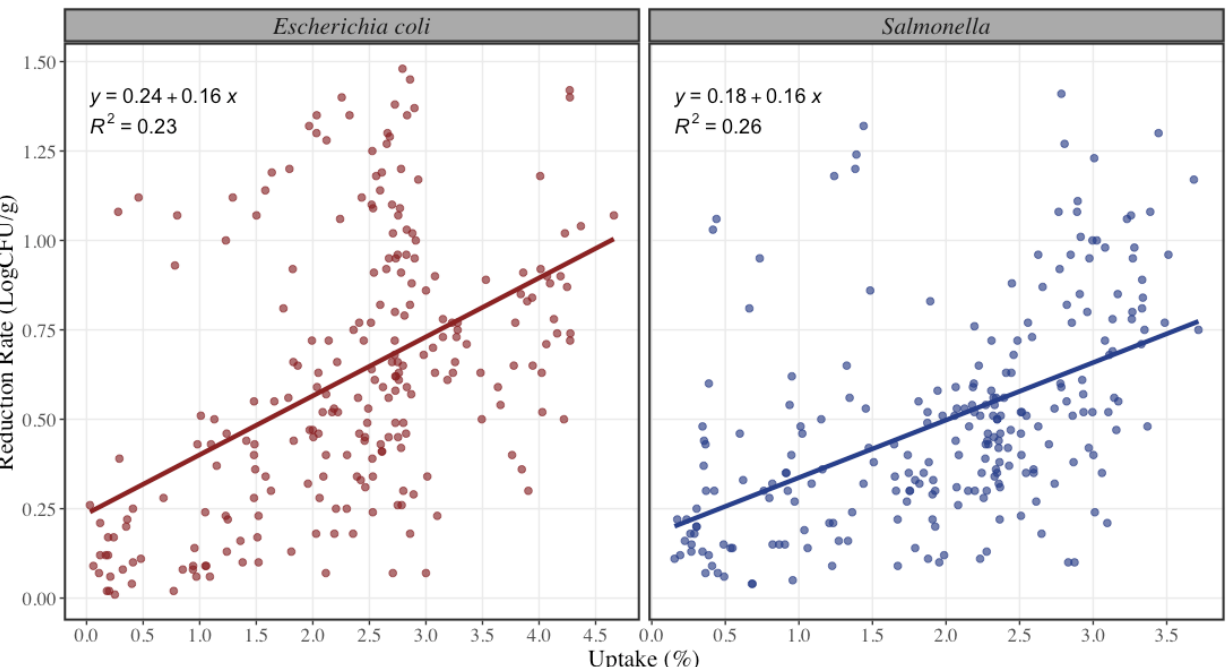
Figure 3. Reduction rate of Shiga-toxin producing Escherichia coli and Salmonella spp. at different uptake percentages ( n = 240 per microorganism). The solid line represents a linear regression model with Uptake (%) as independent variable and Reduction (LogCFU/g) as dependet variable for each pathogen bacteria. The dots represent the actual data points.